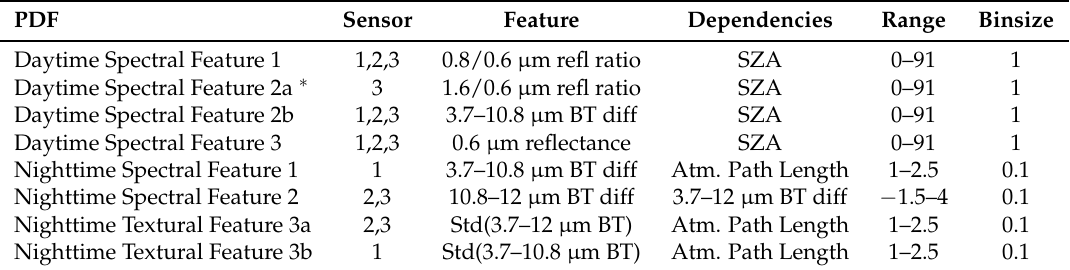
Table 3. Features used for three-way classification PDFs, dependent on AVHRR sensor and time of day. All PDFs are two dimensional with a feature and single dependency. The following acronyms are used: BT = brightness temperature, SZA = solar zenith angle, Atm = Atmospheric, Std = Standard Deviation, diff = difference, refl =